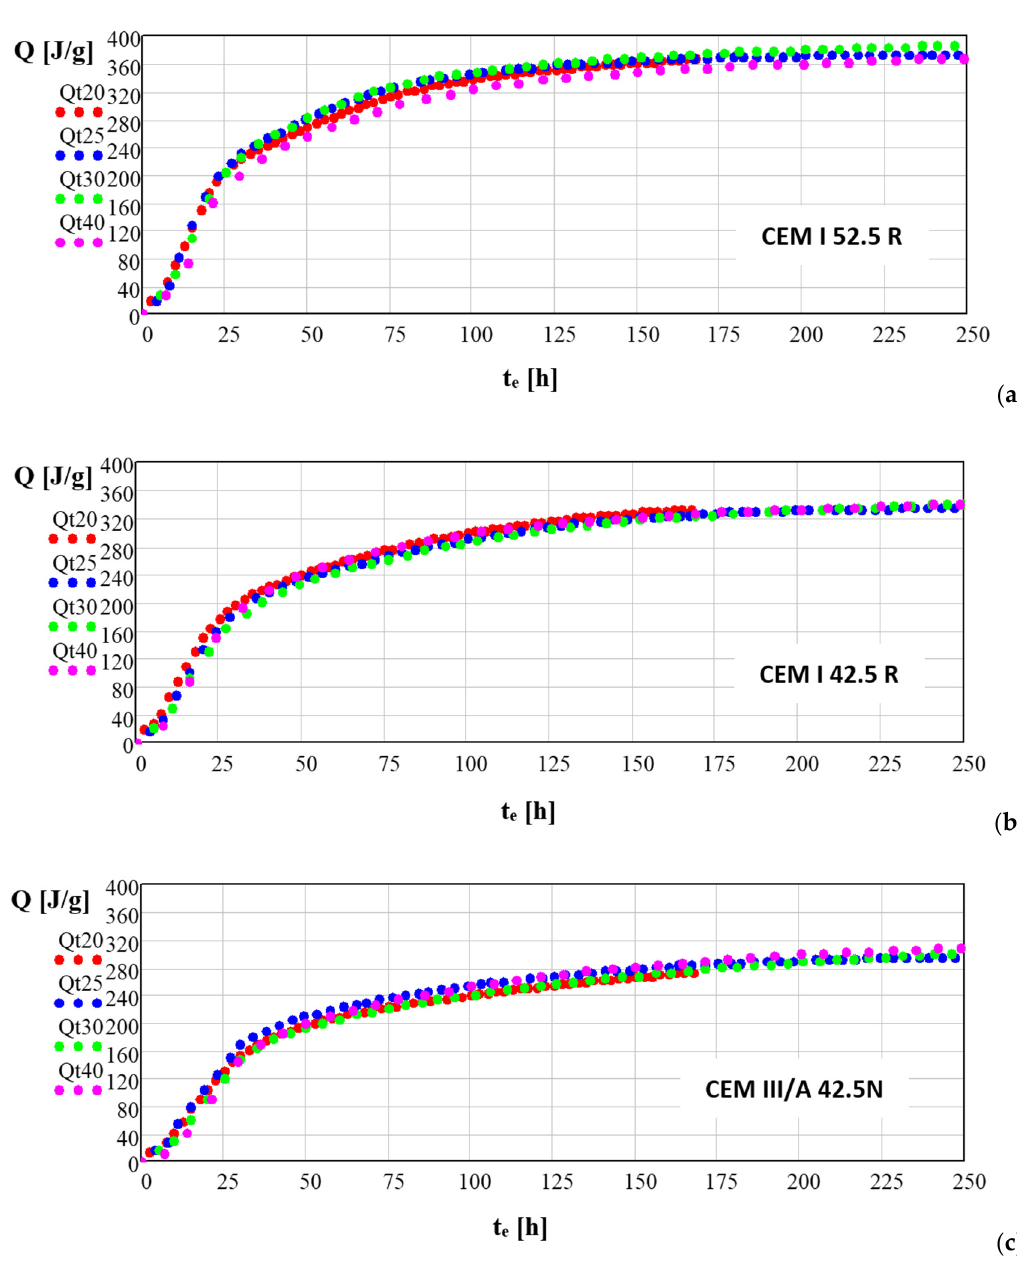
Figure 8. Generated heat Q (J/g) for studied cements in equivalent time function at curing temperatures of 20, 25, 30 and 40 °C. calculated for studied cements ( a ) CEM I 52.5 R, ( b ) CEM I 42.5 R, ( c ) CEM III A 42.5 N.